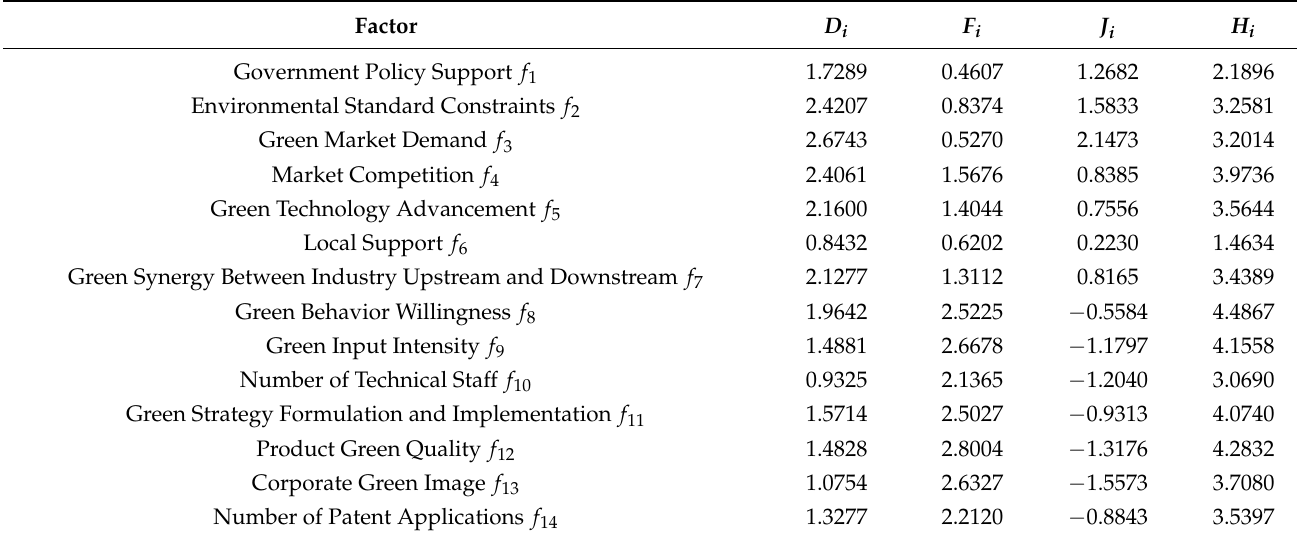
Based on Table 5, factors’ positions in the plane coordinate system were marked to form a diagram of their integrated influence relationship. In this figure, centrality is the horizontal coordinate, reason degree is the vertical coordinate, the intersection of the horizontal and vertical coordinates is [k,0], and the distances from k to the maximum and minimum values of centrality are equal—see Figure 3.